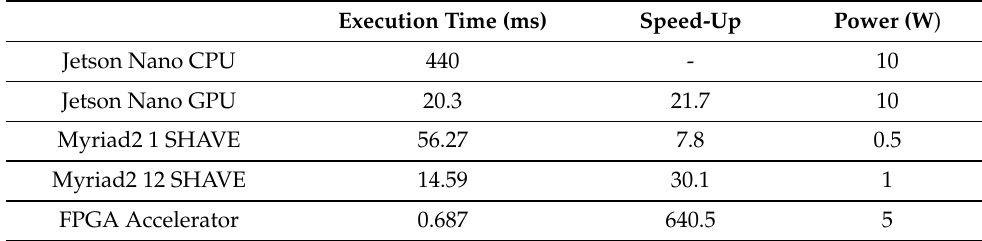
Table 3. Performance and power comparison to edge